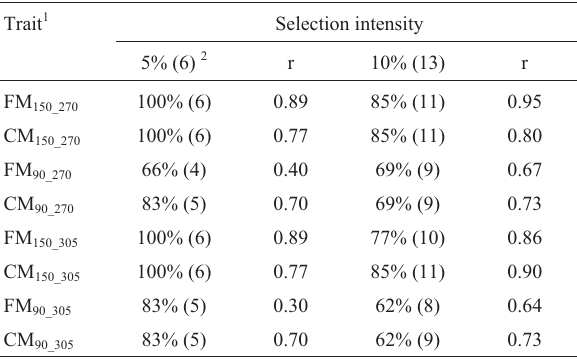
Table 5 - Rank correlations (r), percentage, and number of sires (in paren- theses) selected for adjusted milk yield for days in milk. The values were calculated using different selection intensities based on the predicted breeding values for unadjusted milk